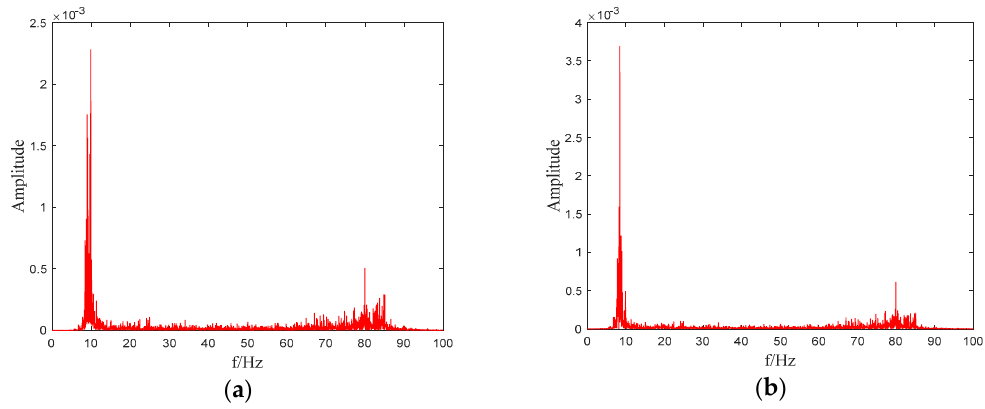
Figure 2. Acceleration power spectral density (PSD) of testing point 5: ( a ) Before damage; ( b ) 50% damage.